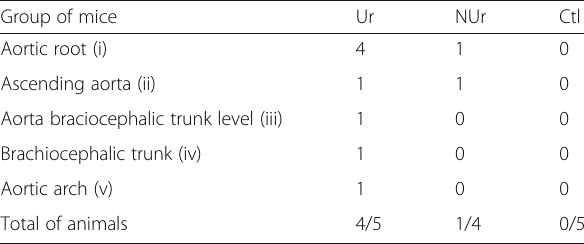
Table 3 Contingency table for MPIO- α VCAM-1 binding localization using T2*-weighted MR images Group of mice